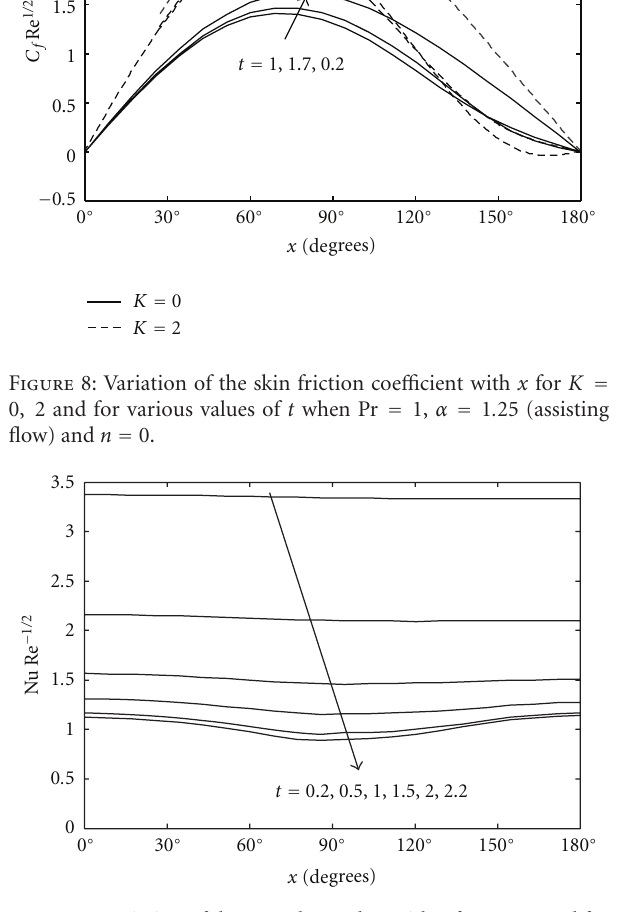
Figure 9: Variation of the Nusselt number with x for K = 2 and for various values of t when Pr = 7, α = − 3 (opposing flow) and n = 0.